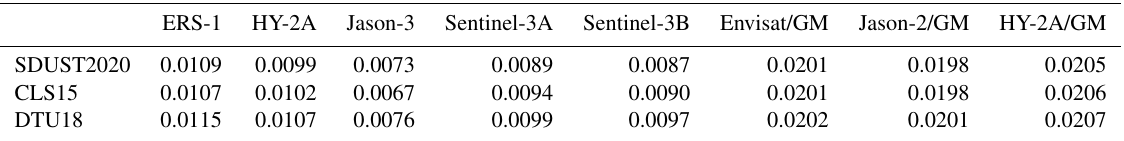
Table 9. SD of SLA for short wavelengths along the track of different altimeters, based on different MSS models (passband filtered from 25 to 150km) (unit: